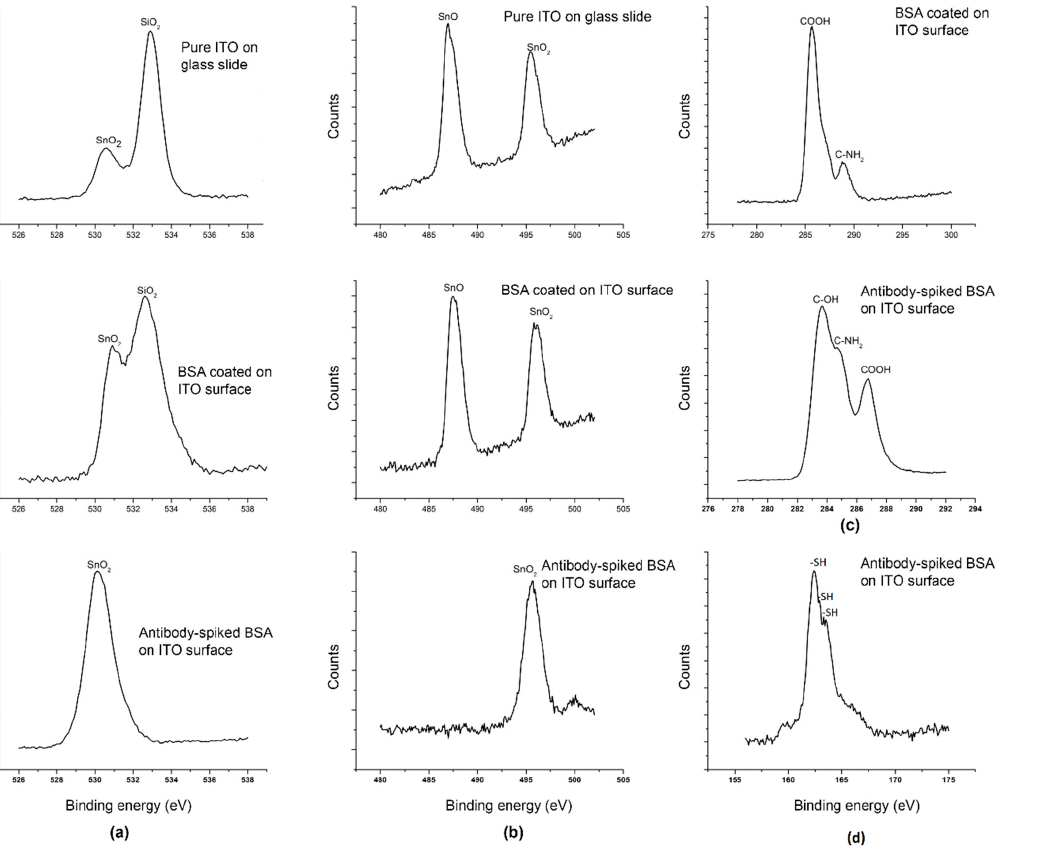
Figure 6. ( a ) The O 1s spectra shows that coating the antibody-spiked BSA on the ITO surface causes a large decrease in the SiOs. ( b ) The presence of the hydroxyl groups for pure ITO on glass and BSA coated on the ITO surface is indicated by the SnO peak. ( c ) The C 1s spectra represents the carboxylic groups on the ITO surface in the presence of BSA and the antibody-spiked BSA. ( d ) The S 2p spectra for ITO with the antibody spiked BSA coated on the ITO surface. In the 2p detailed scan for sulfur, the peak at 162.4 eV corresponds to the thiol bond to metals [43]. The peaks observed at 163.3 and 163.5 eV are assigned to thiol bonds that are not bound to metals. This suggests that some antibodies are directly bound to the Sn on the surface after thiol formation via the reaction we proposed on the surface. This is also consistent with the results of the antibody measurements in Figure 4. The change in resistance of the sensor proves that our device can distinguish between antibodies and the BSA. Comparing Figures 4 and 6c, the catalytic effects of the ITO are different in the case of using pure BSA and using the antibody spiked in BSA on the surface of the ITO as the target. For pure BSA, hydroxyl groups on the surface of the ITO react with carboxylic groups of the BSA. In the case of using antibody spiked in the BSA on the surface ITO, the reaction of hydroxyl groups with disulfide bonds, which are attributed to the antibodies, is clear. Based on our XPS results, the ITO surface coated with BSA does not contain the disulfide or sulfhydryls group. This indicates the disulfide bond of the BSA is far from the ITO surface.